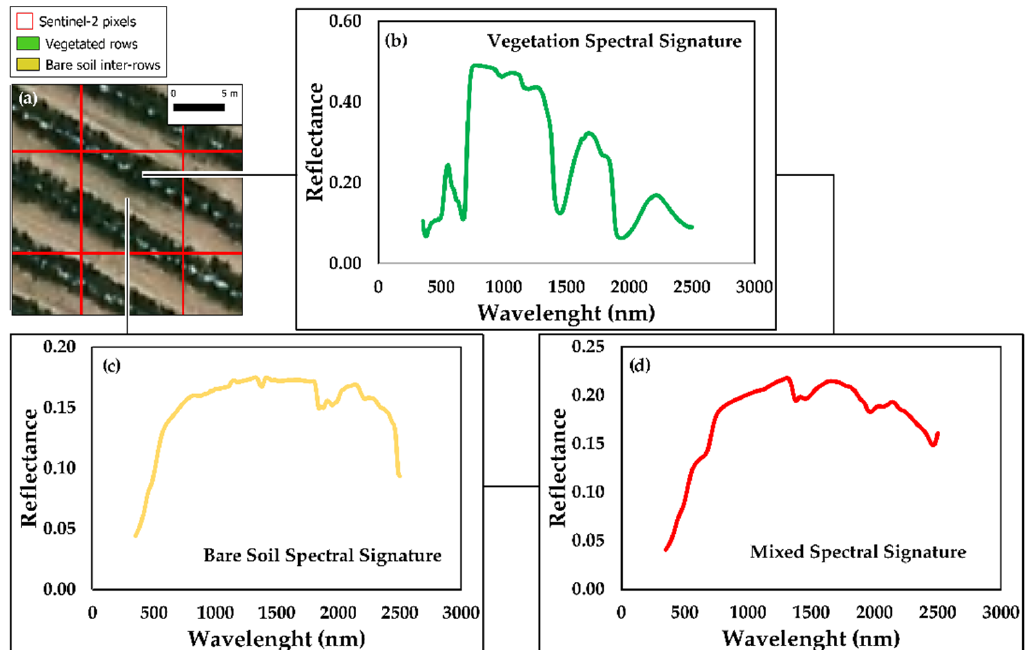
Figure 2. ( a ) Sentinel 2 GSD (red lines) compared with an orchard pattern (within rows + between rows). Graphs ( b – d ) show the effects of the joint spectral contribution of the two classes possibly included in a single S2 pixel: ( b ) spectral signature of “pure” active vegetation; ( c ) spectral signature of “pure” bare soil (clay); ( d ) resulting mixed spectral signature. Spectral signatures ( b – d ) are simply demonstrative (from a ground spectro-radiometer) and used to show the expected spectral effect within a mixed pixel.